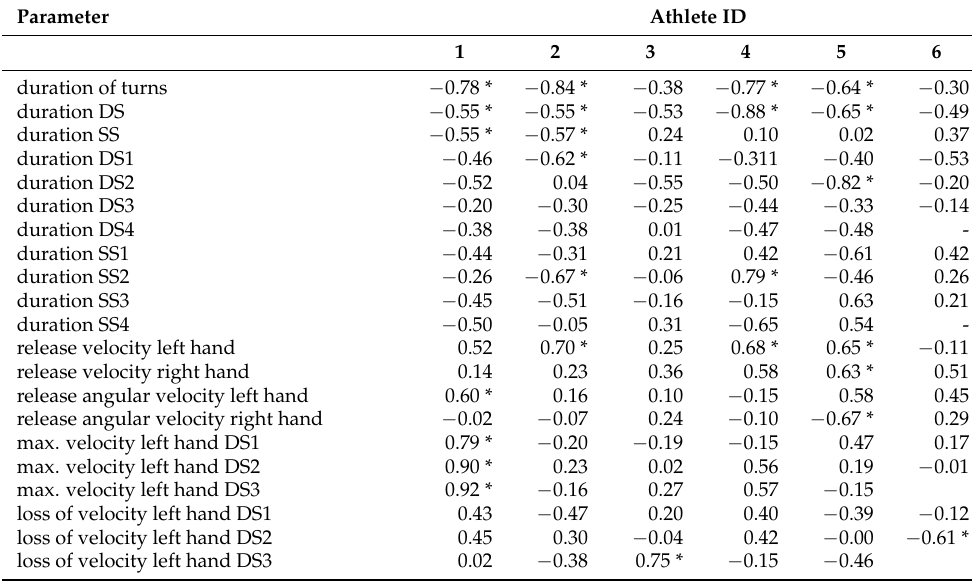
Table A2. Pearson correlation coefficients for all examined